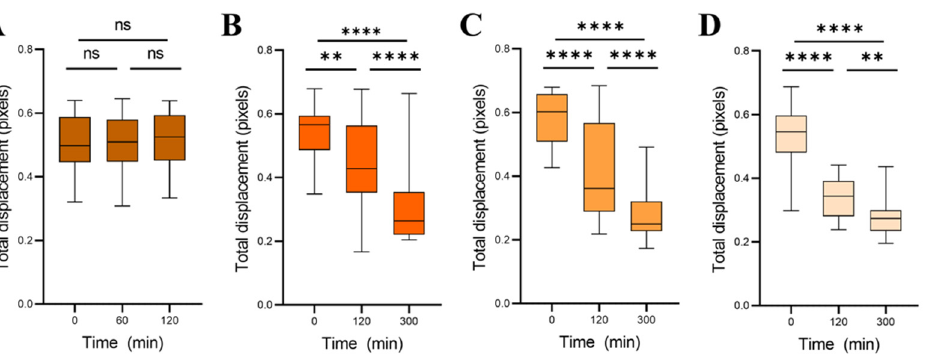
Figure 11. The average cellular nanomotion of 20 cells of C. albicans CAF2-1 wild-type strain. The total displacement of 20 cells was analysed during ( A ) 2 h of growth in a YPD medium (control) and during 5 h of fl uconazole treatment at ( B ) 0.5 µg/mL, ( C ) 1 µg/mL, and ( D ) 100 µg/mL. Wilcoxon test: **** p < 0.0001; ** p < 0.01; ns: not signi fi cant.